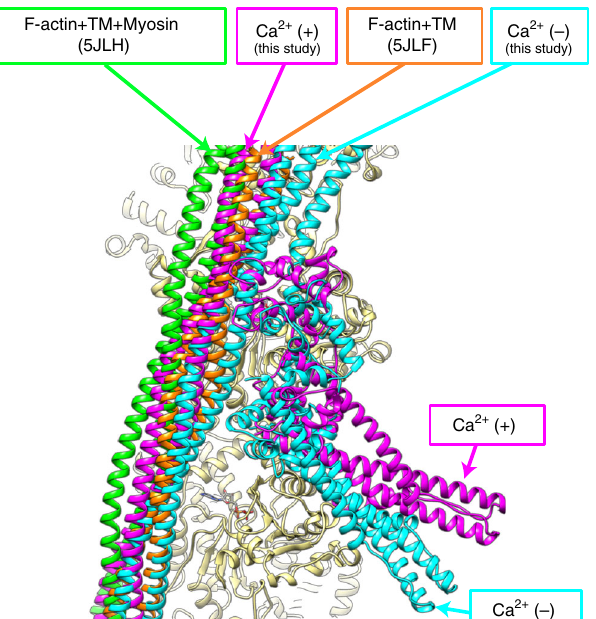
Fig. 5 Positions of Tm coiled coil in the four different states. Models are colored as: actin, beige; Tm and Tn in the Ca 2 + free state, blue; Tm and Tn in the Ca 2 + bound state, magenta; Tm in the actin fi lament – Tm structure, orange; and Tm in the actomyosin fi lament – Tm structure, green. The model 5JLH 23 is a human actomyosin – tropomyosin complex composed of the motor domain of human non-muscular myosin-2C, cytoplasmic γ -actin, and cytoplasmic tropomyosin 3.1, and the model 5JLF 23 is composed of rabbit skeletal muscle actin and recombinant α -tropomyosin from Mus musculus with an alanine – serine extension in its